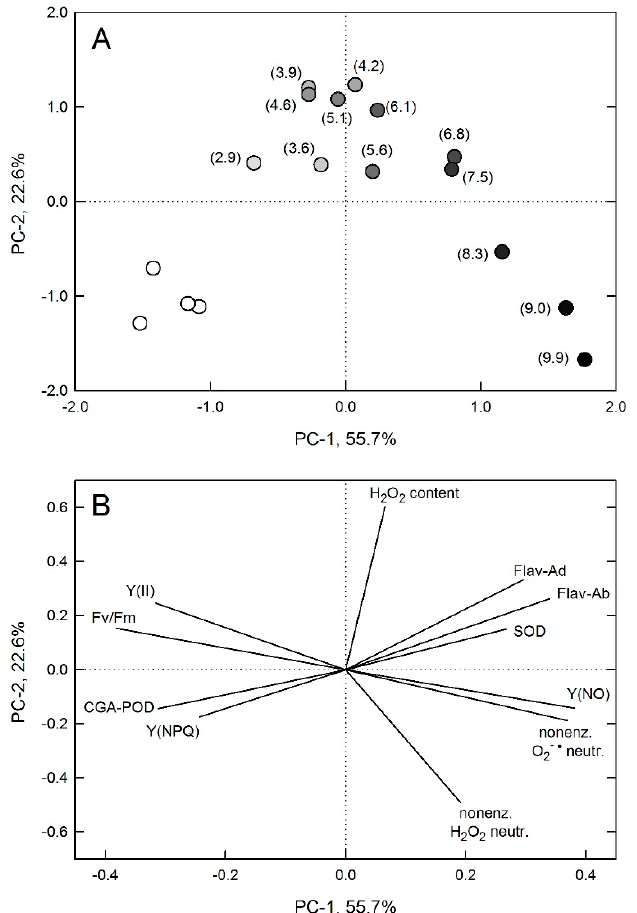
Figure 7. Principal component (PC) analysis of correlations. ( A ) Data points. Empty symbols mark untreated leaves and filled symbols represent UV-B treated leaves: darker shades of grey corresponding to higher fluxes. Numbers in parenthesis are UV-B fluxes in μ mol m − 2 s − 1 units. ( B ) Projections of UV-B responsive original variables. Adaxial and abaxial leaf flavonoid index (Flav-Ad and Flav-Ab, respectively); non-enzymatic hydrogen peroxide and superoxide neutralising capacities (nonenz. H 2 O 2 neutr. and nonenz. O 2–• neutr., respectively); maximum and light acclimated photochemical quantum yields (F v /F m and Y(II), respectively); yields of regulated and non-regulated non-photochemical quenching (Y(NPQ) and Y(NO), respectively); superoxide dismutase (SOD) and chlorogenic acid dependent peroxidase (CGA-POD) enzyme activities; and leaf H 2 O 2 content.